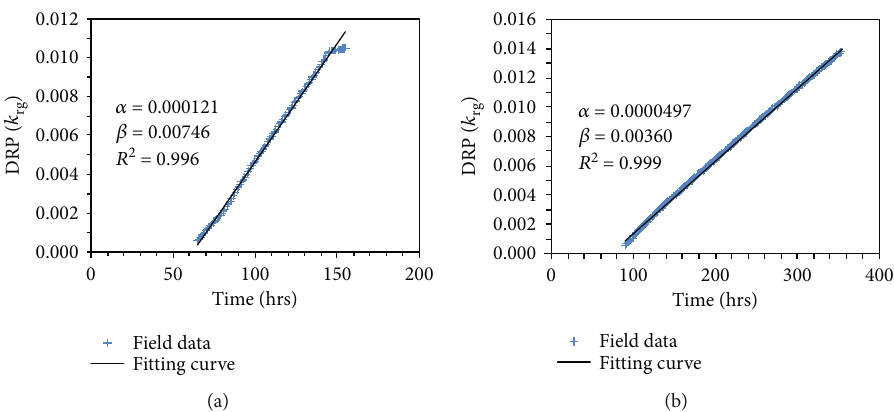
Figure 9: Dynamic relative permeability function over time considering stress sensitivity for two wells in shale gas formations belonging to southern Sichuan. (a) DRP fi tting curve for Well 3. (b) DRP fi tting curve for Well 4.